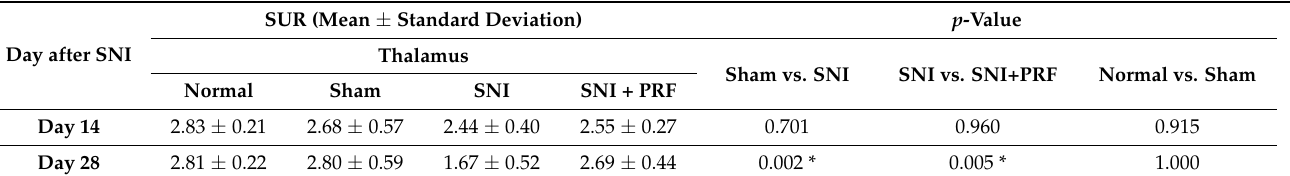
Table 1. SURs in thalamus in each group.